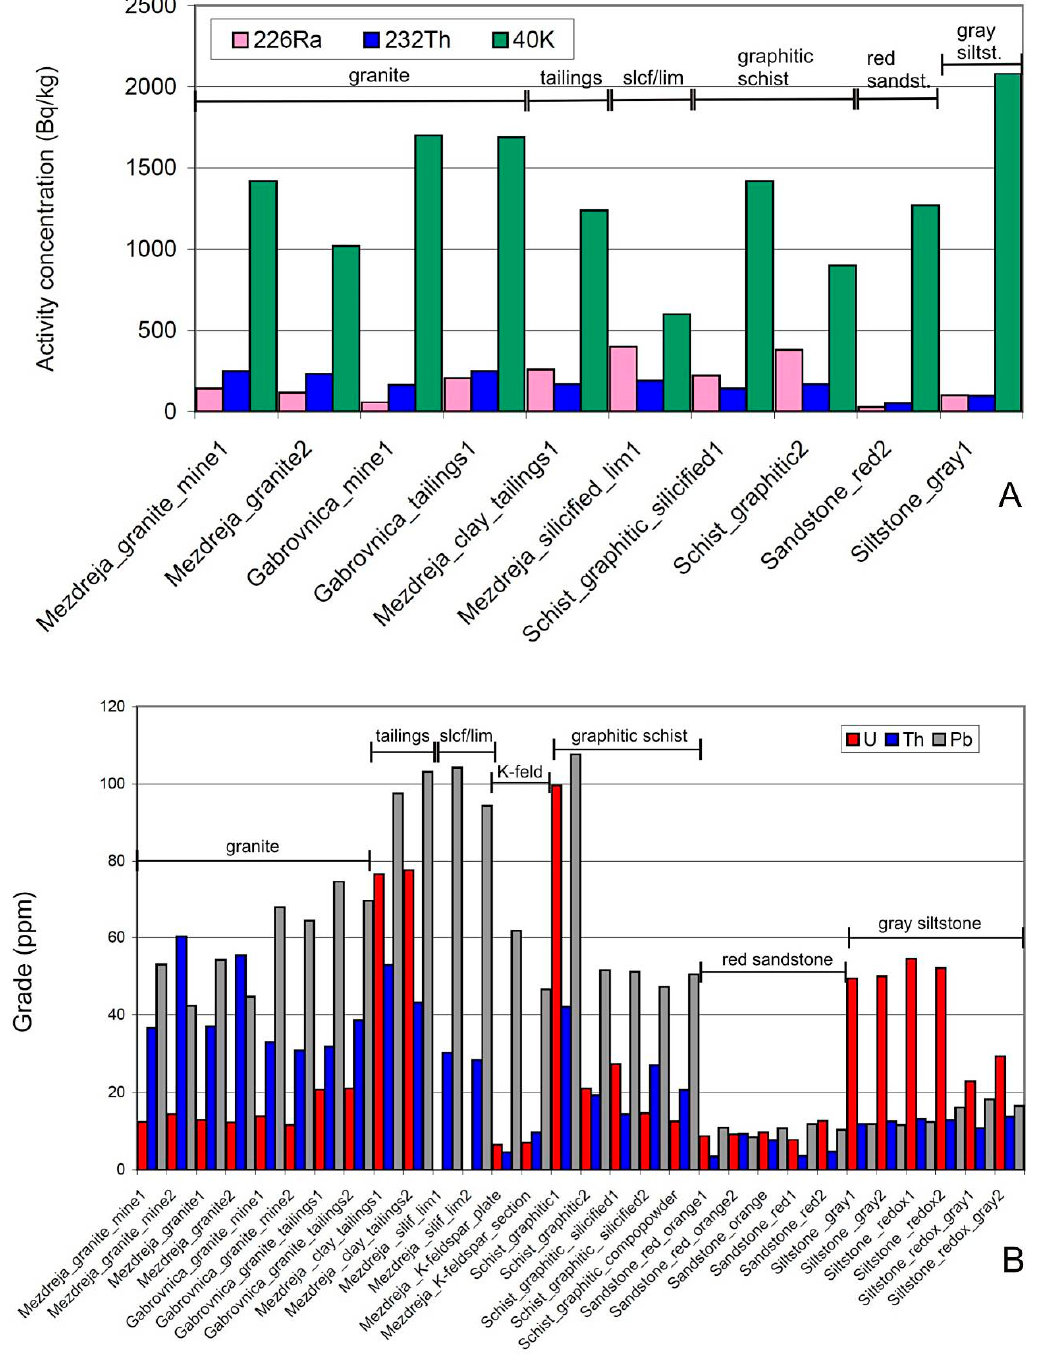
Figure 5. ( A ) Activity concentrations of 226 Ra, 232 Th and 40 K (Bq/kg); ( B ) grades of U, Th and Pb in sample assays (ppm). sample assays